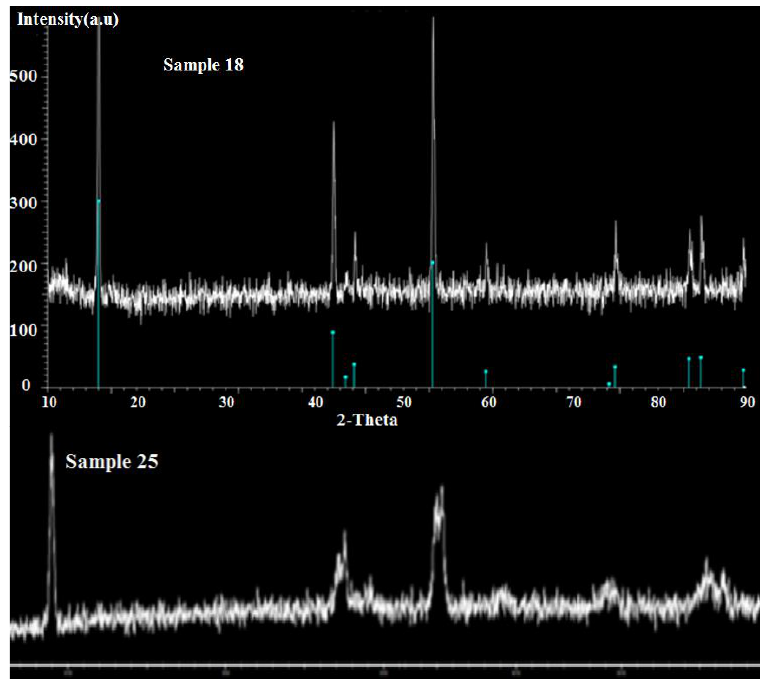
Figure 4. XRD plots of sample 18 from the current system.